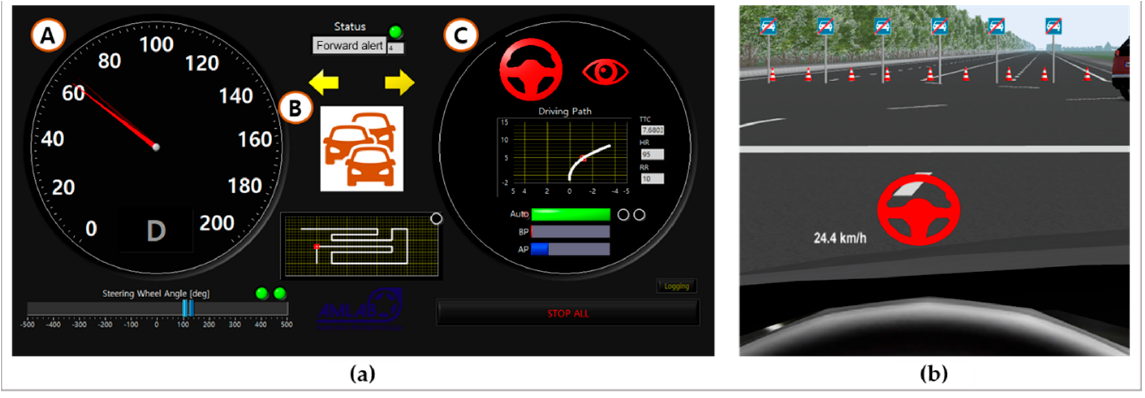
Figure 7. Visual interface: (a) cluster monitor and (b) HUD.